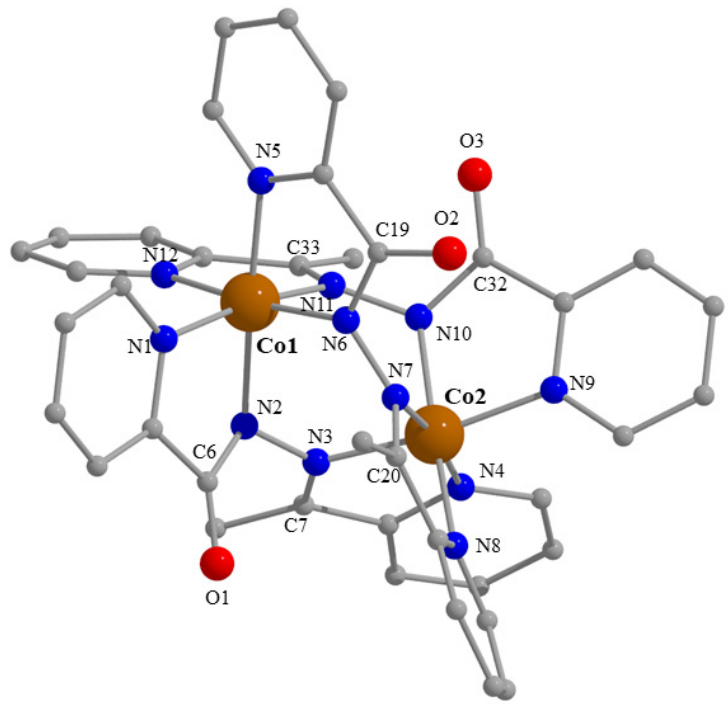
Figure 7. Partially labelled plot of the cation [Co 2 (L) 3 ] 3+ that is present in the crystal structure of 3· 0.8H 2 O·1.3MeOH. A plot with thermal ellipsoids is presented in Figure S21 (left).